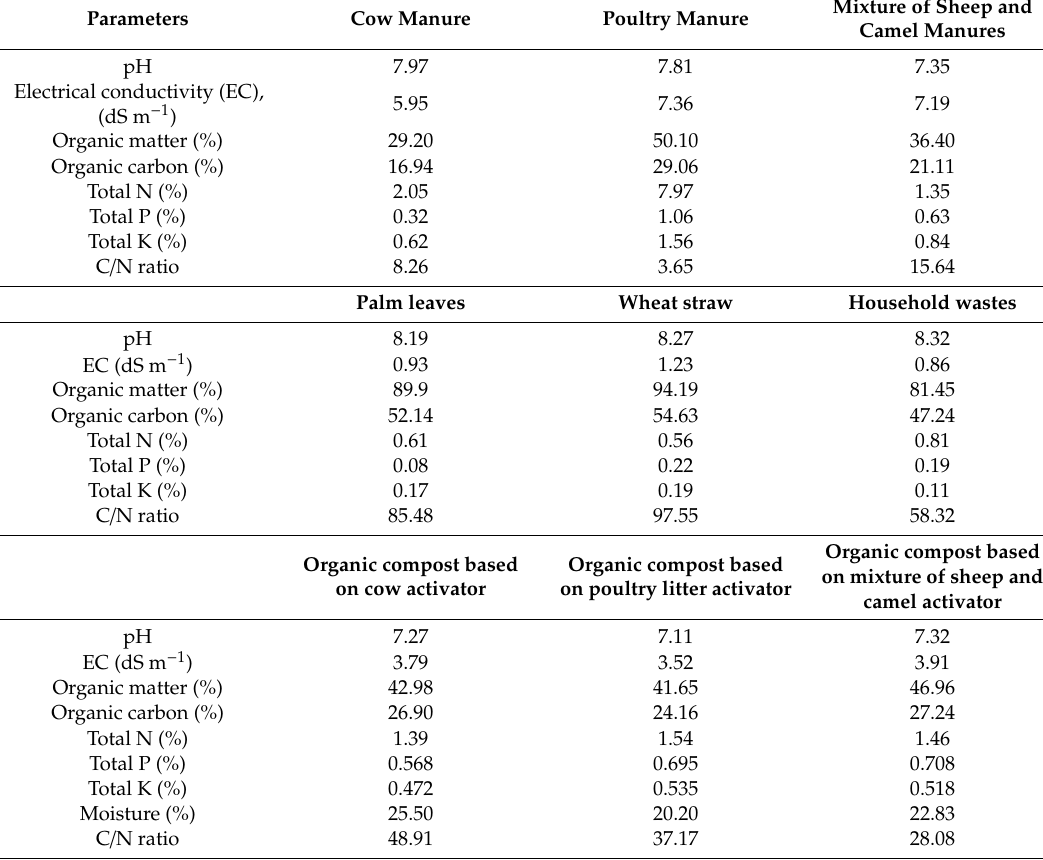
Table 1. Chemical composition of the three types of organic manures used as activators in preparing the di ff erent organic composts, the raw waste materials used in preparing di ff erent organic composts, and the three types of organic composts at the end of the composting period (120